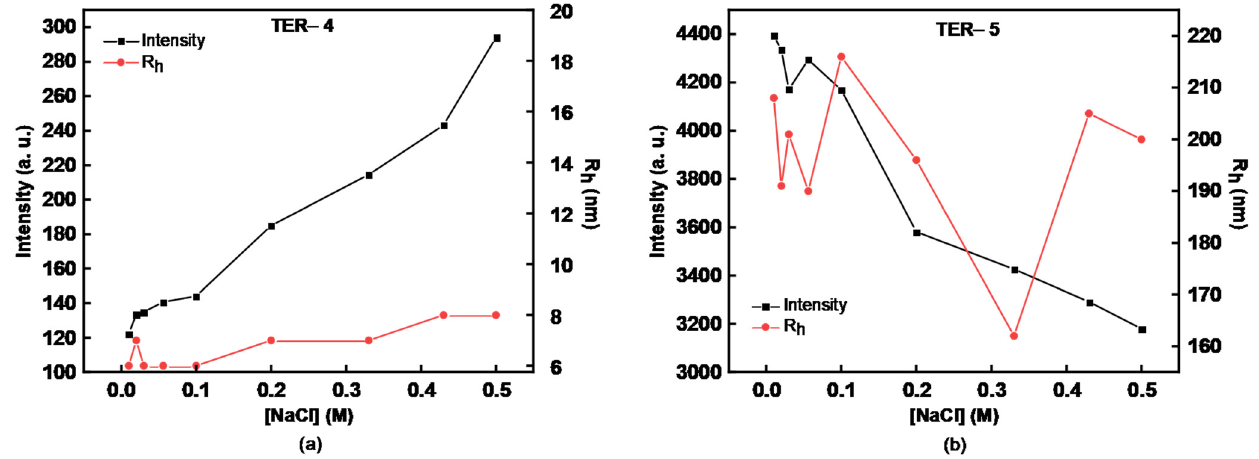
Figure 8. Ionic strength plots for ( a ) TER-4 and ( b ) TER-5 terpolymers (polymer concentration 10 − 3 g/mL, at pH = 3 and at a temperature of 25